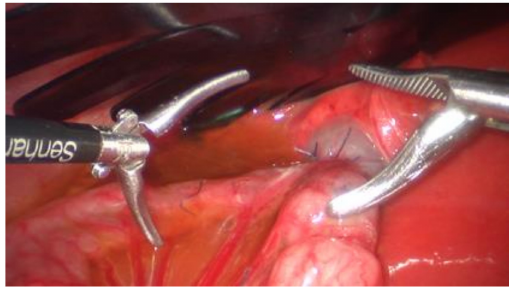
Figure 7. Robotic assisted (Senhance, Transenterix) cholecystoenterostomy in a 5 kg piglet with 3 mm and 5 mm instruments. The size of the instruments compared to the gallbladder and intestine demonstrates the small size of the cavity in which it is being